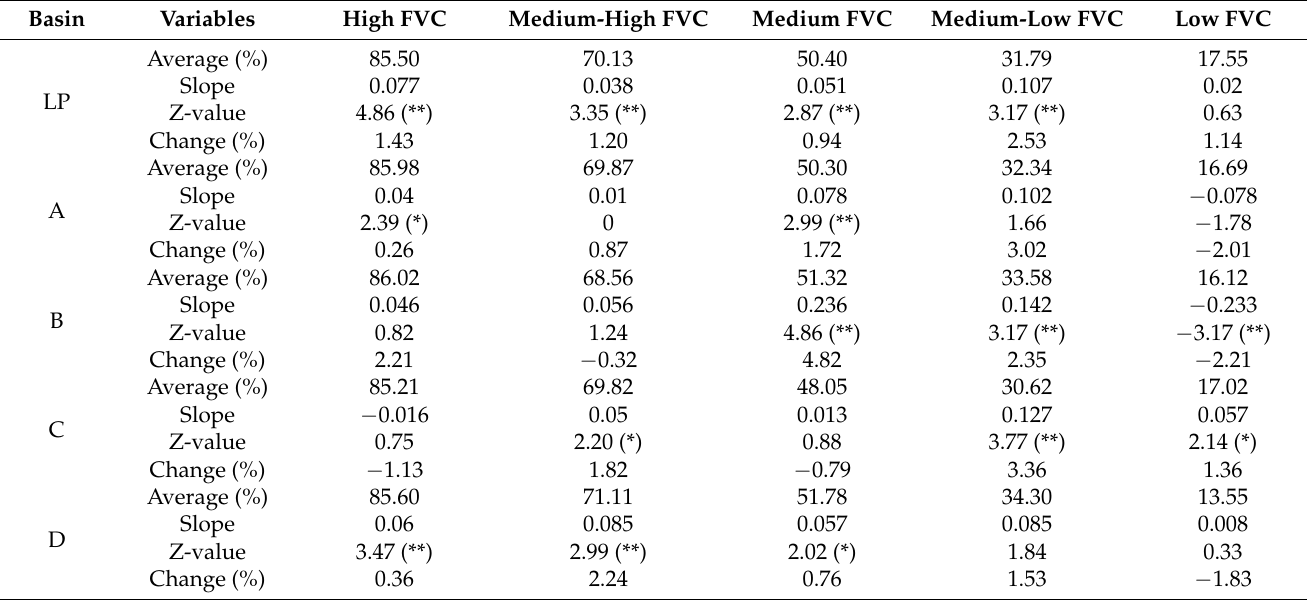
Table 2. FVC of different grades on the LP from 2000 to